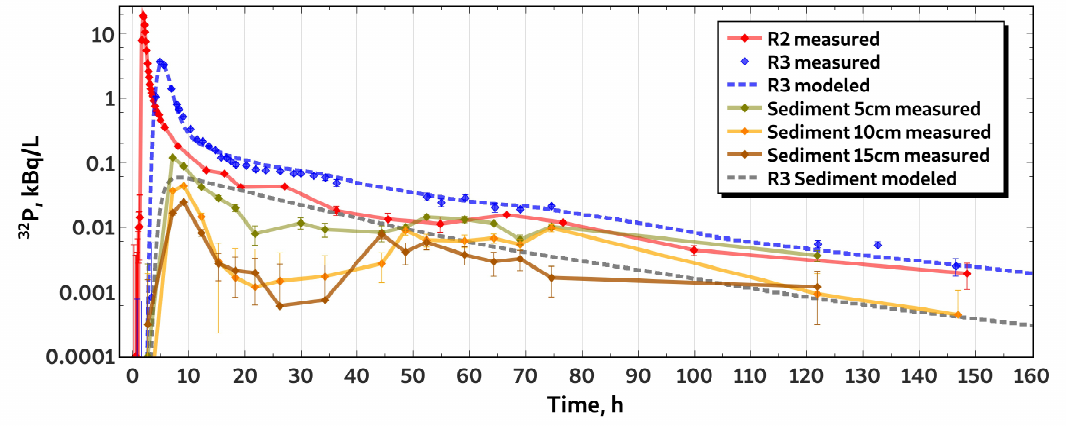
Figure 8. The 32 P activity concentrations observed at R2 and R3, and modeled at